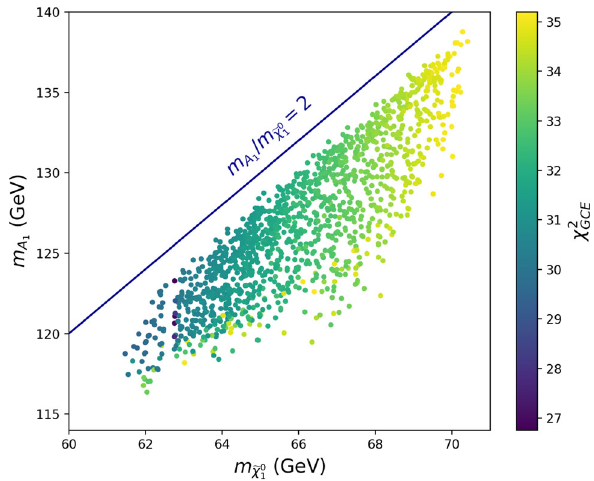
Fig. 1 GCE-samples plotted on the plane of m (cid:2) χ 0 color denoting (cid:3) σv (cid:4) 0 , i.e. the DM annihilation cross section in today’s Fig. 2 GCE-samples plotted on the plane of m (cid:2) χ 0